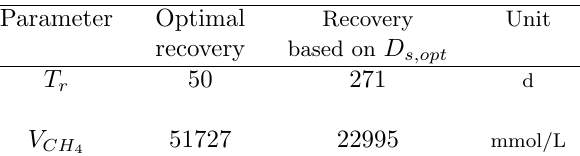
Table 5: Comparison regarding the recovery time and the volume of the produced methane over 400 days between two methane recovery proce-